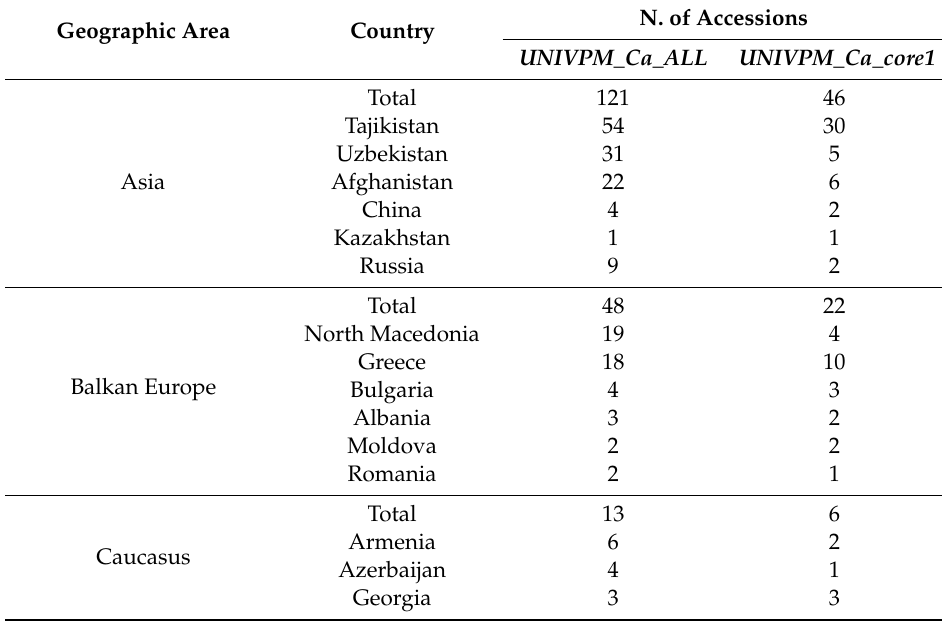
Table 1. Number of accessions for each country of origin and geographic area for UNIVPM_Ca_ALL and UNIVPM_Ca_core1